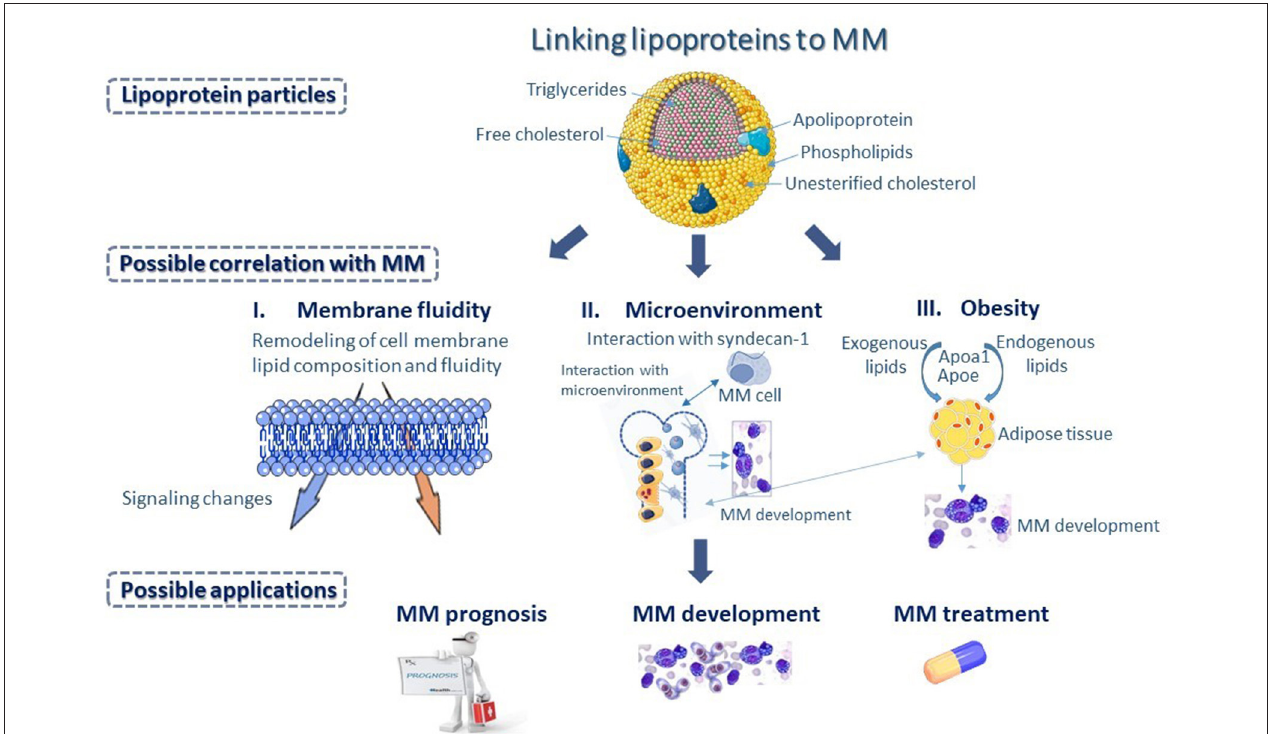
FIGURE 3 | Differences in apolipoprotein and lipid composition of the various lipoprotein classes could represent a potential biomarker, linking lipoproteins to multiple myeloma (MM). Changes in lipoprotein metabolism could influence membrane fluidity of MM cells (I), as serum lipoproteins play important role in the remodeling of lipid composition and fluidity of cell membrane, and subsequently could bring about changes in intracellular signaling, affecting functional properties of MM cells. Changes in lipoprotein metabolism could also bring about changes in the bone marrow (BM) microenvironment (II) possibly through interaction with syndecan-1, found on the surface of MM cells that has a key role in the interaction of MM cells with the BM microenvironment. Additionally, changes in lipoprotein metabolism affect adipocyte formation and play a major role in the progression of morbid obesity (III) supporting MM development. Possibly, Apolipoprotein A1 (APOA1) and Apolipoprotein E (ApoE), which are major contributors to diet-induced obesity may influence processes associated with the development and progression of MM.